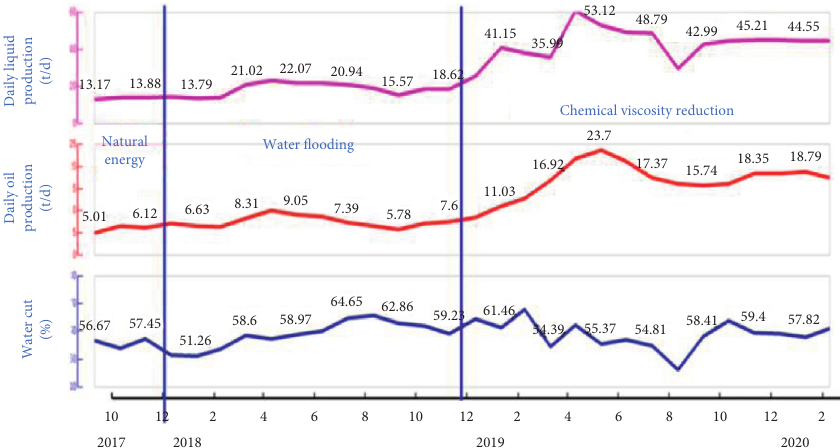
Figure 11: Production curve of the chemical viscosity-reducing development of the test well group in the Jin 8 block.